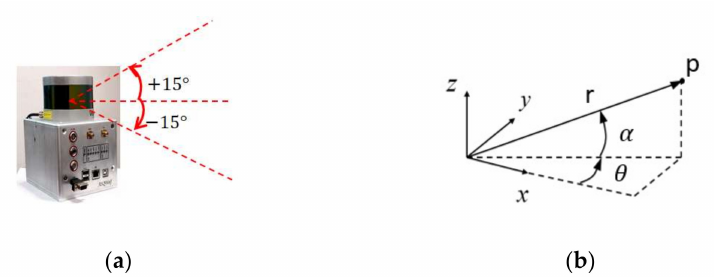
Figure 1. The ASQWolf system with the Velodyne VLP-16 scanner. ( a ) The ASQWolf is handheld to obtain data and ( b ) the coordinate transform is from the cylindrical coordinate system to the rectangular coordinate